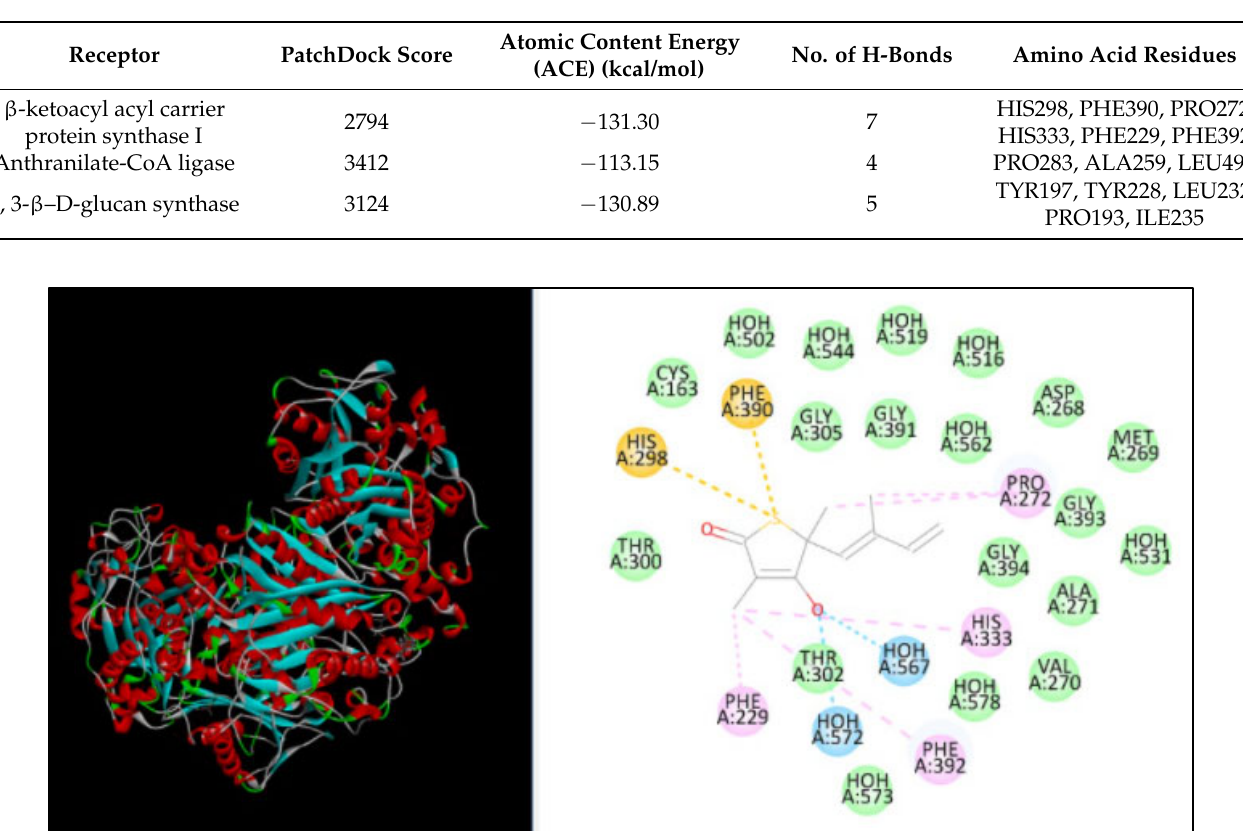
Figure 4. Interaction of β‐ ketoacyl acyl carrier protein synthase I with fenchone.